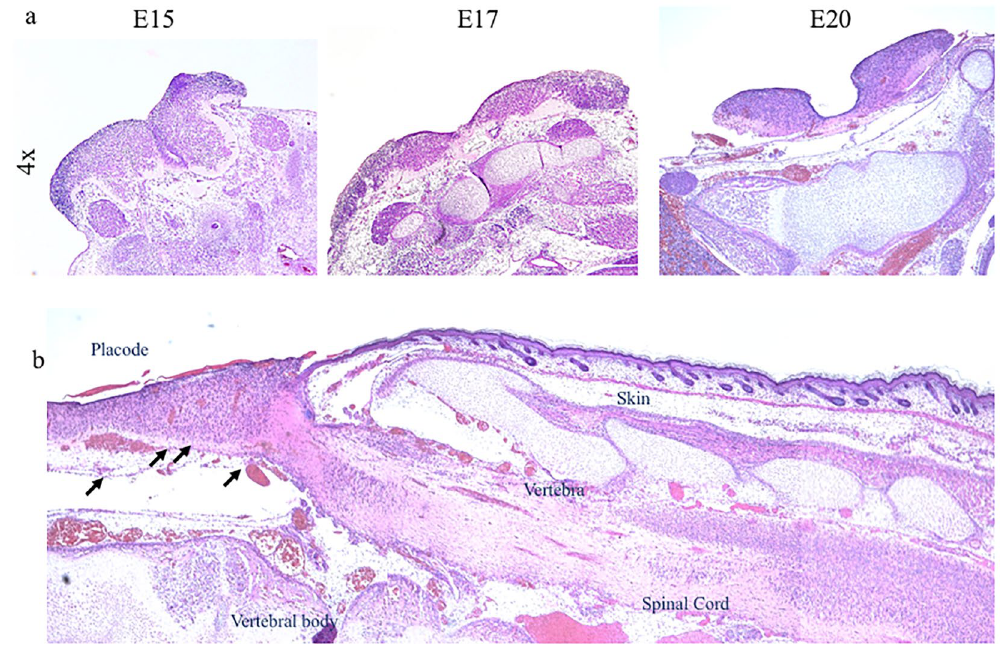
Figure 1. RA-induced spina bifida aperta in rat fetuses during gestation showing spinal cord sections by hematoxylin and eosin (H & E) stain. ( a ) Exposed cord at gestational days E15, E17, and E20 (4 × ). ( b ) At E20 (sagittal view), exposed cord shows altered cellular density and blood vessel extravasation (arrows) (4 ×